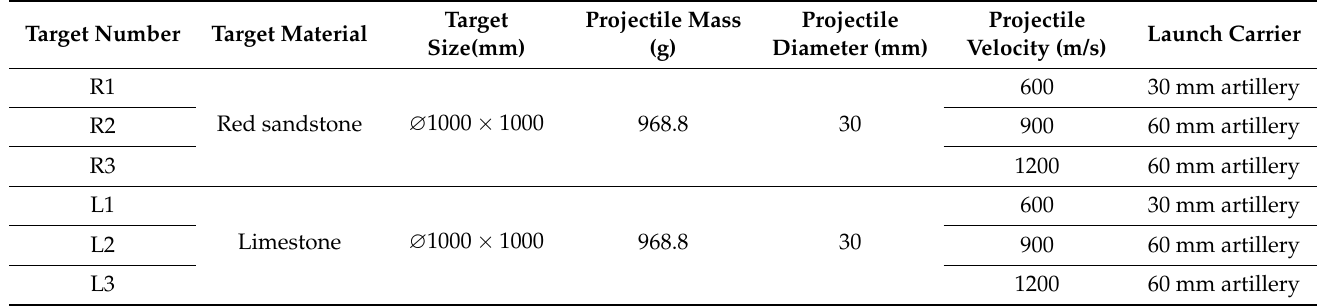
Figure 3. Test target: ( a ) red sandstone target; ( b ) limestone target. Table 4. Test scheme.